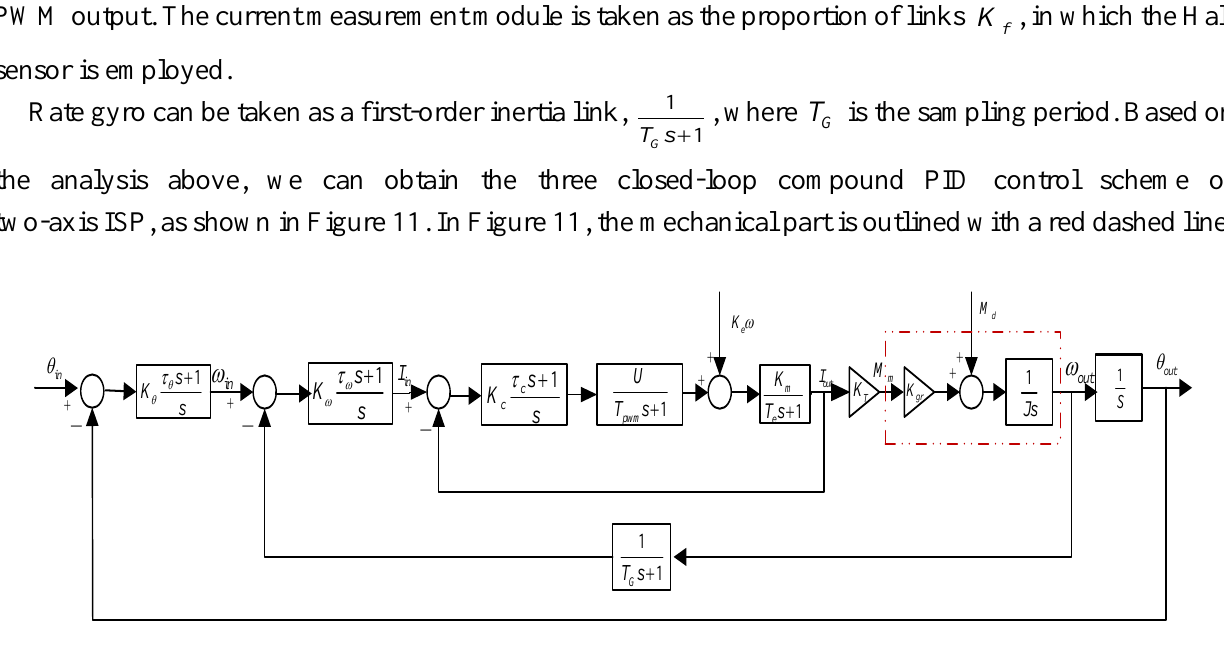
Figure 11. Block diagram of three closed-loop compound PID control scheme of two-axis